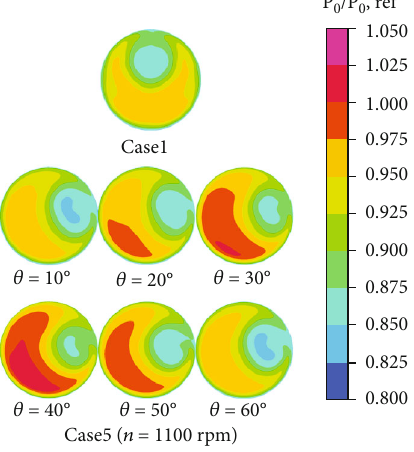
Figure 14: Total pressure distribution for di ff erent blade positions ( θ